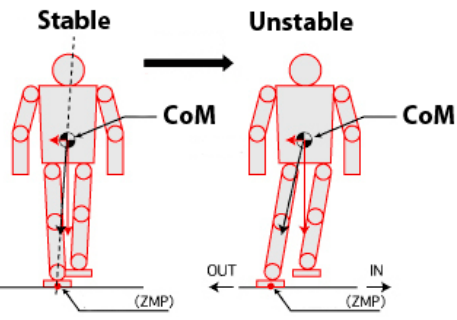
Figure 1. Zero Moment Point (ZMP) concept (CoM is the center of mass).